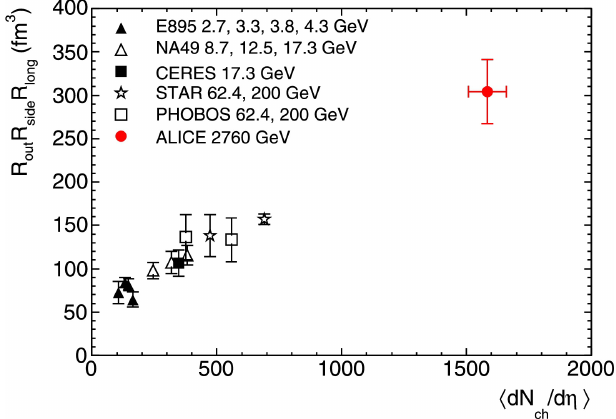
Figure 1. Volume of the source as a function of (cid:104) d N ch /d η (cid:105) from two-pion HBT correlation: lower energy results are reported as well for comparison. Figure taken from